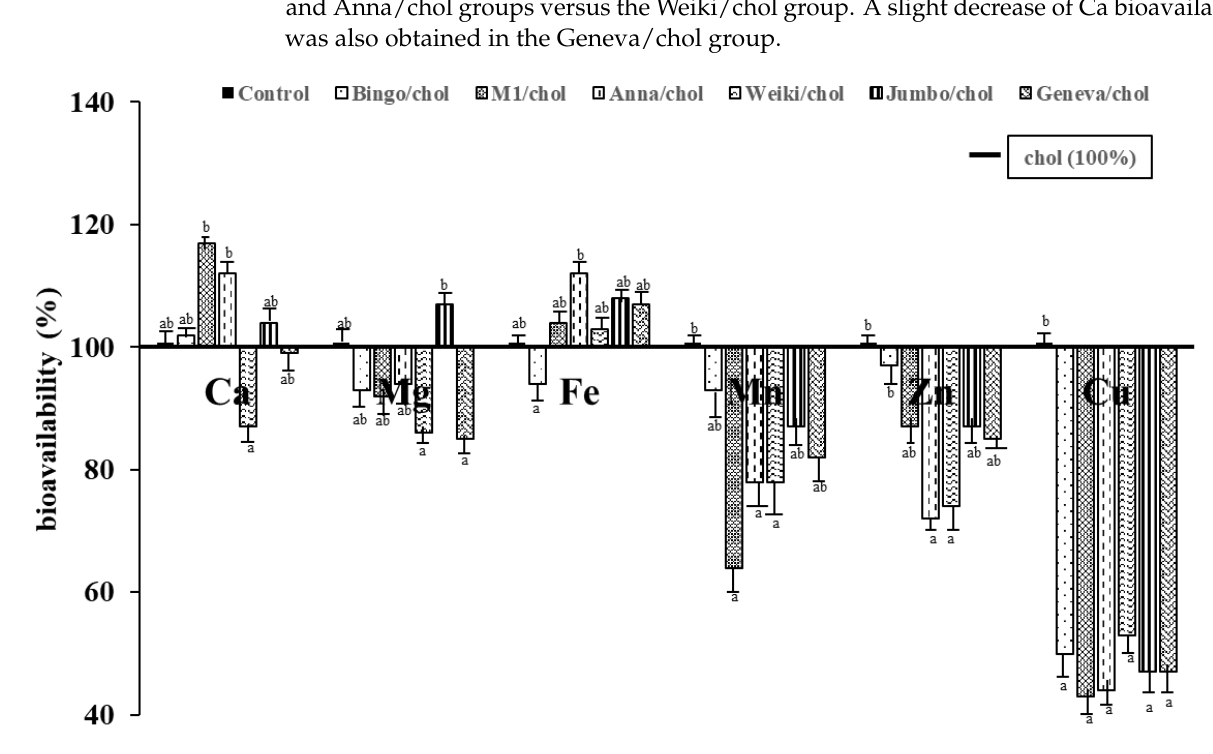
Figure 1. Bioavailability of macro- and microelements in rats fed diets with kiwiberry fruits and cholesterol. a,b —columns marked with different letters differ at p < 0.05 ( n = 7). Abbreviations: control—rats receiving control diet, chol—rats receiving control diet with 1% of cholesterol, the horizontal line (100%), Bingo/chol—rats receiving diet with 1% of cholesterol and 5% of Bingo fruits, M1/chol—rats receiving diet with 1% of cholesterol and 5% of M1 kiwiberry, Anna/chol—rats receiving diet with 1% of cholesterol and 5% of Anna kiwiberry, Weiki/chol—rats receiving diet with 1% of cholesterol and 5% of Weiki kiwiberry, Jumbo/chol—rats receiving diet with 1% of cholesterol and 5% of Jumbo kiwiberry, Geneva/chol—rats receiving diet with 1% of cholesterol and 5% of Geneva kiwiberry.